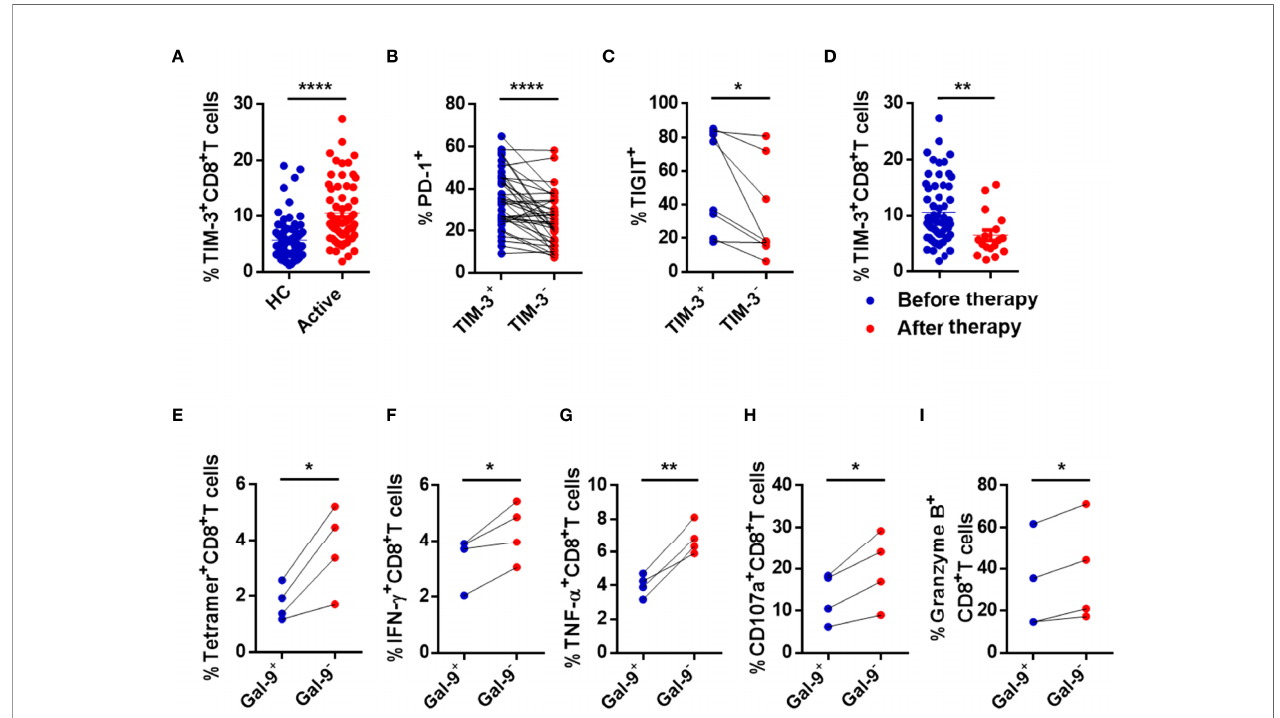
FIGURE 4 | CD8 + T cells are immune exhausted through the Gal-9/TIM-3 axis in active CHB patients. (A) Comparison of the levels of TIM-3 expressed in circulating CD8 + T cells in active CHB patients and HCs. (B) The percentages of PD-1 expressed in TIM-3 + CD8 + T cells and TIM-3 - CD8 + T cells in peripheral blood from active CHB patients. (C) The percentages of TIGIT expressed on TIM-3 + CD8 + T cells and TIM-3 - CD8 + T cells in peripheral blood from active CHB patients. (D) The percentage of TIM-3 expressed on CD8 + T cells in peripheral blood from active CHB patients with or without antiviral treatment, respectively. (E – I) Gal-9 + NK, Gal-9 - NK, and CD8 + T cells were sorted from active CHB patients, cocultured in vitro , and stimulated with anti-CD3/anti-CD28 for 3 days. The frequency of tetramer + CD8 + T cells (E) and the production of the cytokines IFN- g , TNF- a , CD107a, and granzyme B (F-I) by CD8 + T cells were analyzed. Results are expressed as the mean ± SEM, and the number of samples (n) in each group was ≥ 3. Unpaired t-test was used to compare two independent groups. A paired t-test was used to compare paired samples. *P < 0.05; **P < 0.01; ****P <